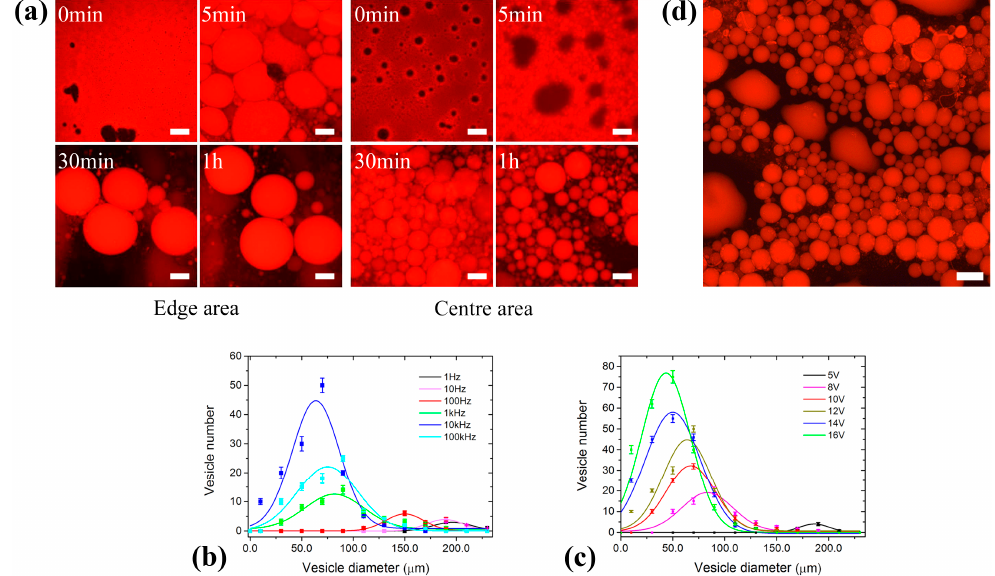
Figure 2. ( a ) The GUV formation process in the edge and central area, respectively, under the electric field of 12 V and 1 kHz. The deposited lipid film swelled into membrane domains first, then closed gradually and detached finally to form vesicles. ( b , c ) The scatter diagram and Gaussian fitting curves for GUV diameters at different frequencies (12 V) and voltages (10 kHz), respectively. Where, the GUV number was obtained by specifying a box (1 mm × 1 mm) at the center and edge, respectively, and then added them up. The GUVs with diameter within the interval of (0, 20) were classified into d = 10 μ m, and so on. ( d ) The formed GUVs at 16 V and 10 kHz. The scale bar is 100 μ m.